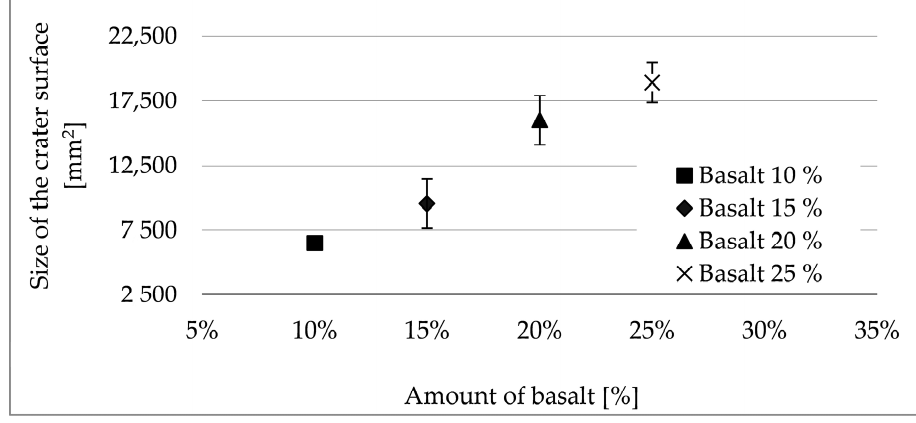
Figure 19. Size of the rear crater area according to individual percentage substitutions.